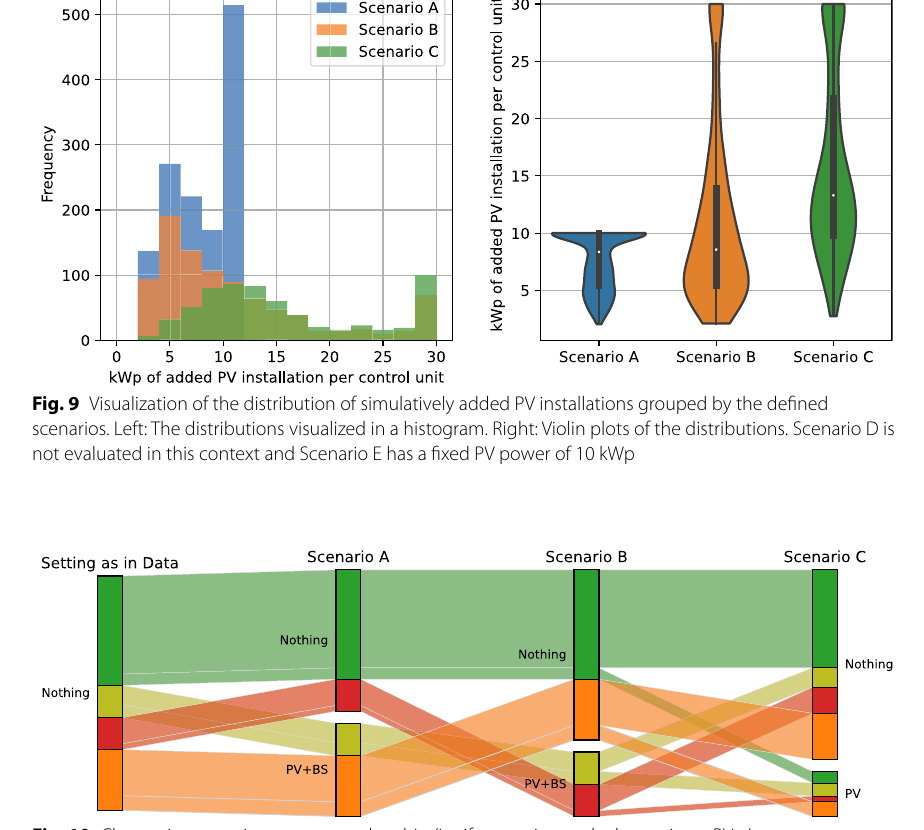
Fig. 10 Change in expansion group membership (i.e. if expansion took place using a PV- / PV-battery-installation or not) for the different evaluated scenarios. The different trajectories are colored differently. We can see that the selected control units for adding components changes significantly depending on the scenario. Scenario D and Scenario E are not shown for the sake of